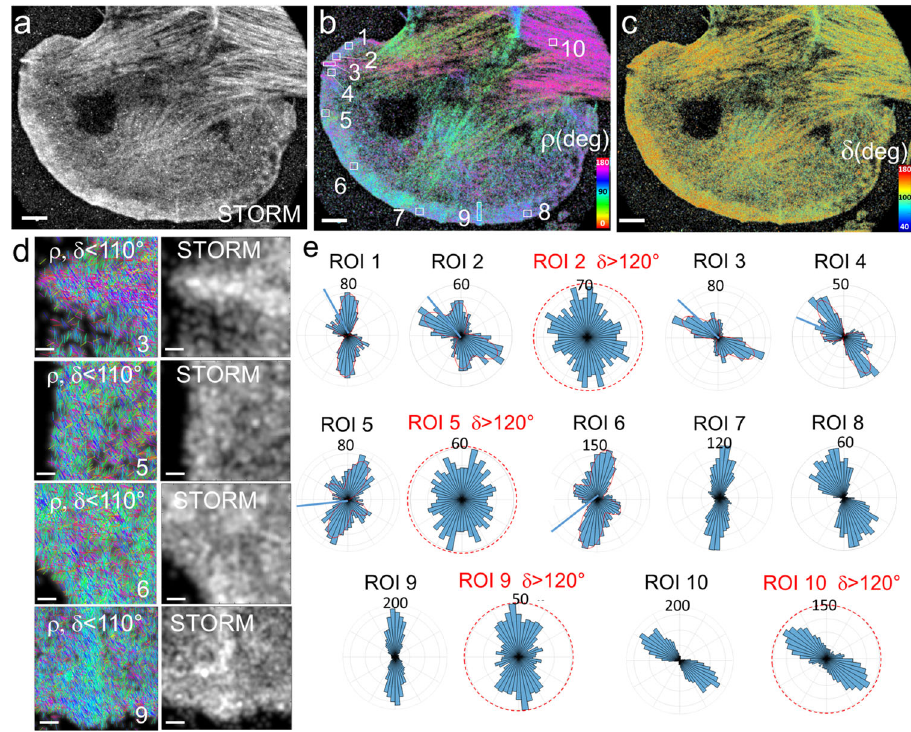
Fig. 5 4polar-STORM imaging of actin fi lament organization in lamellipodia. a Single-molecule localization STORM image of a B16 cell labeled with AF488-phalloidin. b Corresponding 4polar-STORM ρ stick image with color-coded orientation measurements. c 4polar-STORM δ stick image with color- coded wobbling angle measurements. 4polar-STORM images were repeated independently on four different cells with similar results. d Examples of ρ stick images showing molecules with δ < 110° and corresponding STORM images in selected ROIs (squares in ( b )). ROIs 1 – 9, regions in the lamellipodium; ROI 3,9, microspikes; ROI 10, SF. e Polar-plot histograms of ρ for the regions shown in ( b ). The condition δ < 110° is used, except for red-circled histograms for which δ >120° molecules are selected. The red lines in ROIs 1 – 6 are fi ts of the ρ histograms that resemble bimodal distributions. The blue lines in these same ROIs correspond to the normal direction of the cell membrane in the respective ROI. Angle between the two peaks around the membrane normal direction, obtained from the fi ts: ROI1 (60°), ROI2 (59°), ROI3 (50°), ROI4 (52°) ROI5 (70°), ROI6 (73°). Scale bars ( a – c ), 4 μ m; ( d ), 260 nm. Source data are provided as a Source Data fi